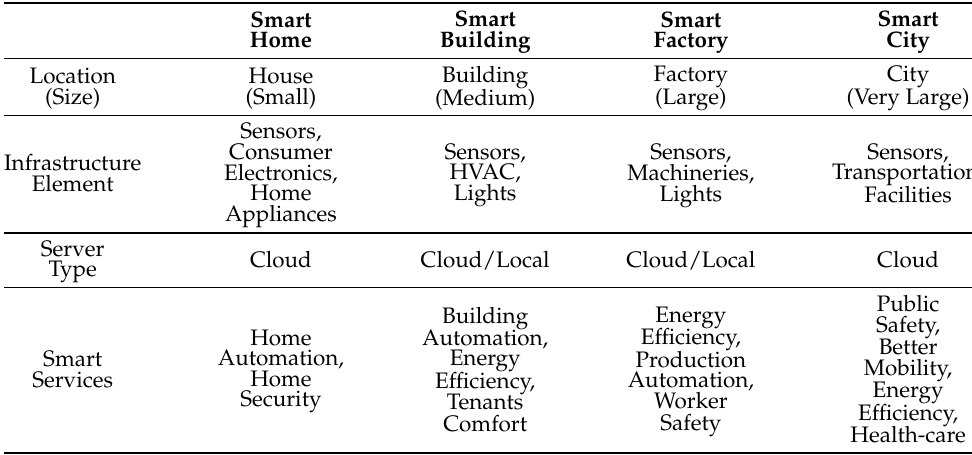
Table 1. Comparison of four domain